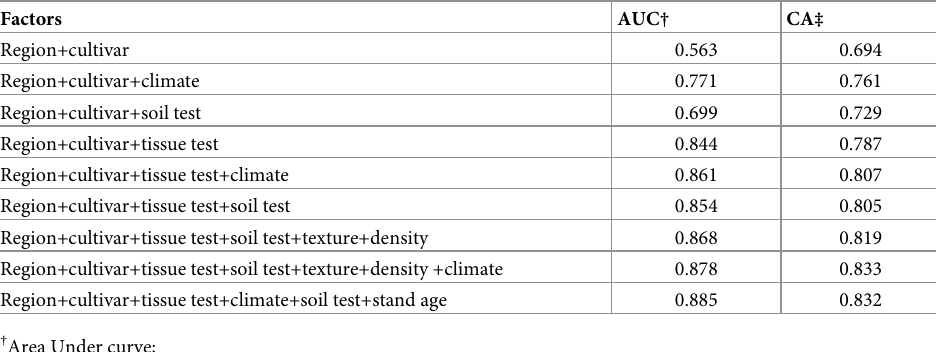
Table 3. Factor contribution to ML model